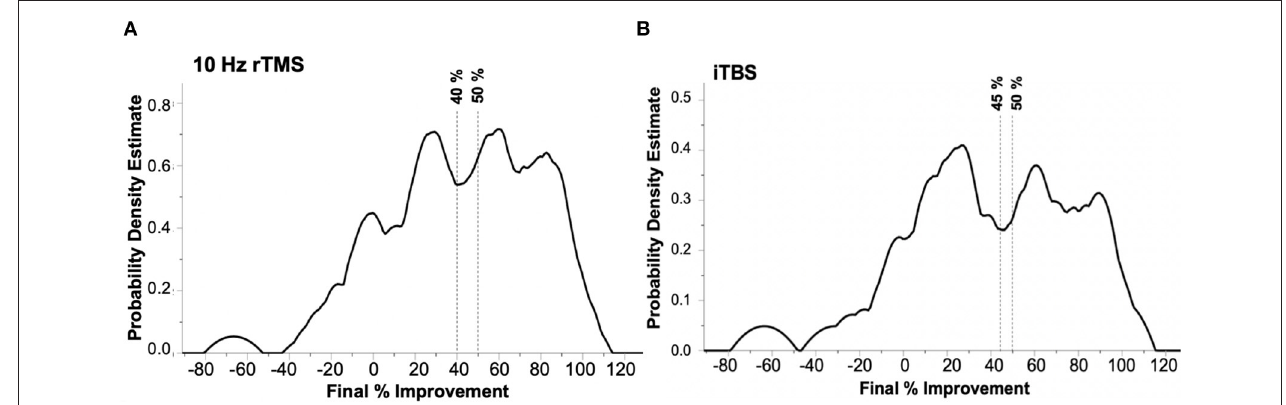
FIGURE 2 | Kernel density estimate (KDE) depicting the modality specific distribution of treatment outcomes as determined by percentage improvement of PHQ-9 scores from baseline to final treatment. (A) Kernel density estimates (KDE) with Epanichnikov kernels of participants that received 10Hz rTMS ( n = 68) demonstrating a non-normal distribution with distinct sub-group of “non-responders” at 40% compared to the traditional 50% final improvement cut-off. (B) KDE of participants receiving iTBS ( n = 37) with distinct “non-responder” sub-group at 45% compared to traditional 50% final improvement